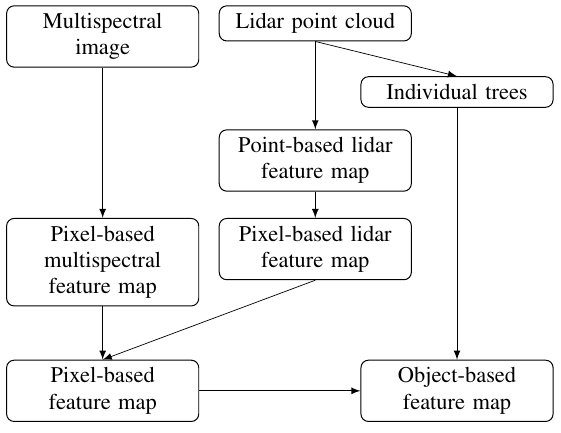
Figure 2. Feature extraction flowchart.